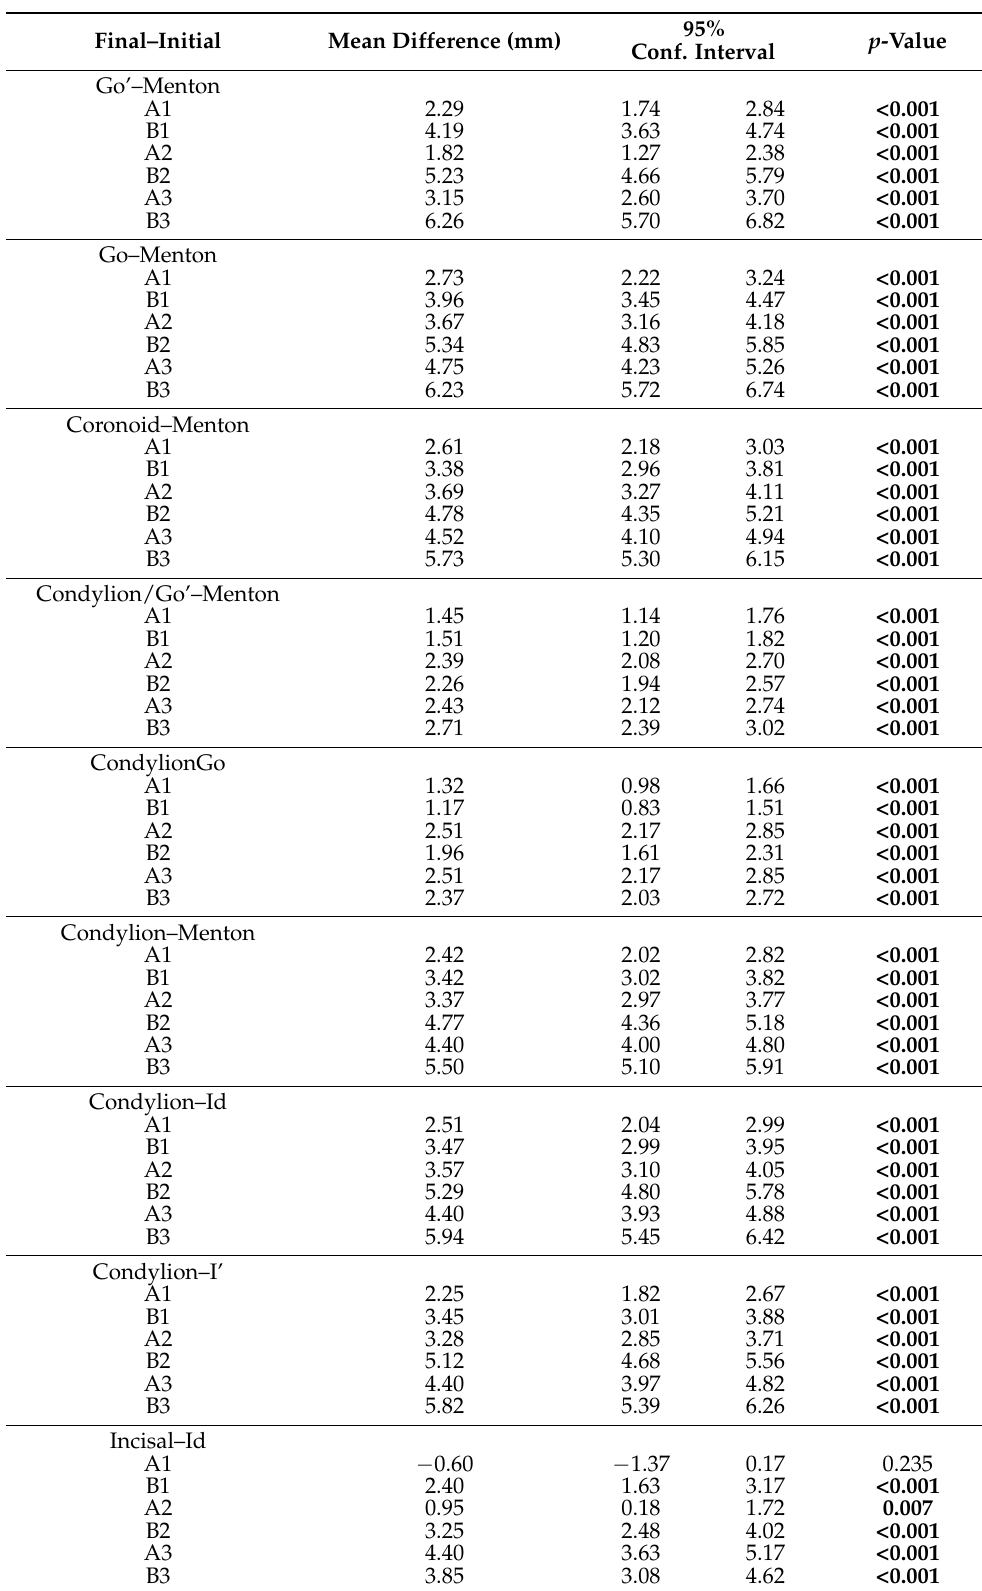
Table 6. Estimated mean differences (final–initial), 95% Confidence Intervals and p -values (compared to 0 i.e., no change) per group and